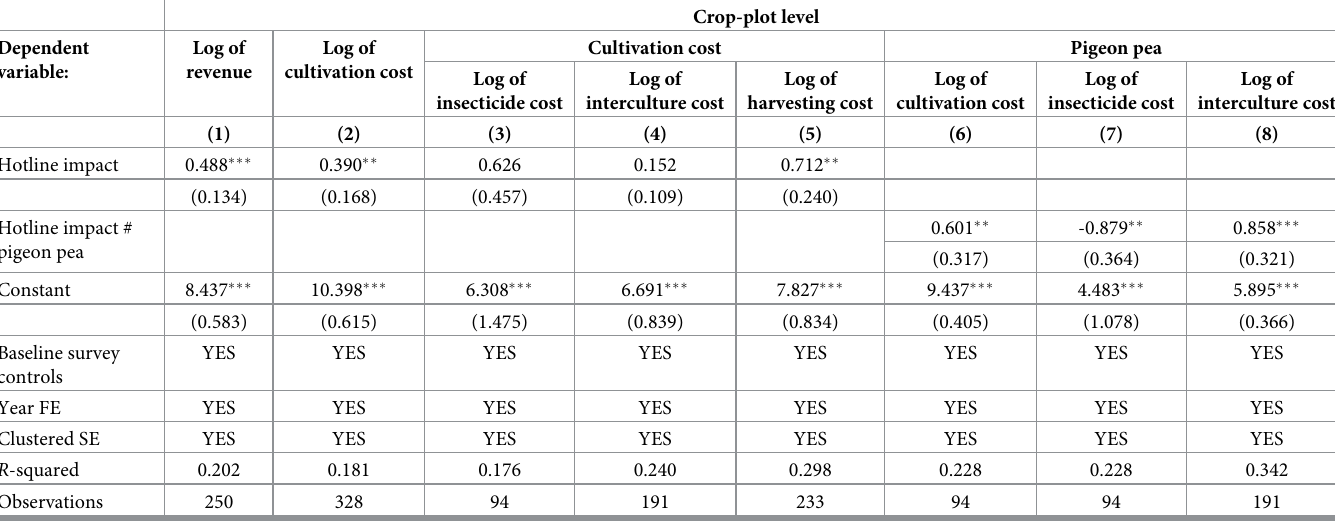
Table 2. Regression of cultivation practices on hotline impact, pigeon pea hotline impact, and other baseline survey